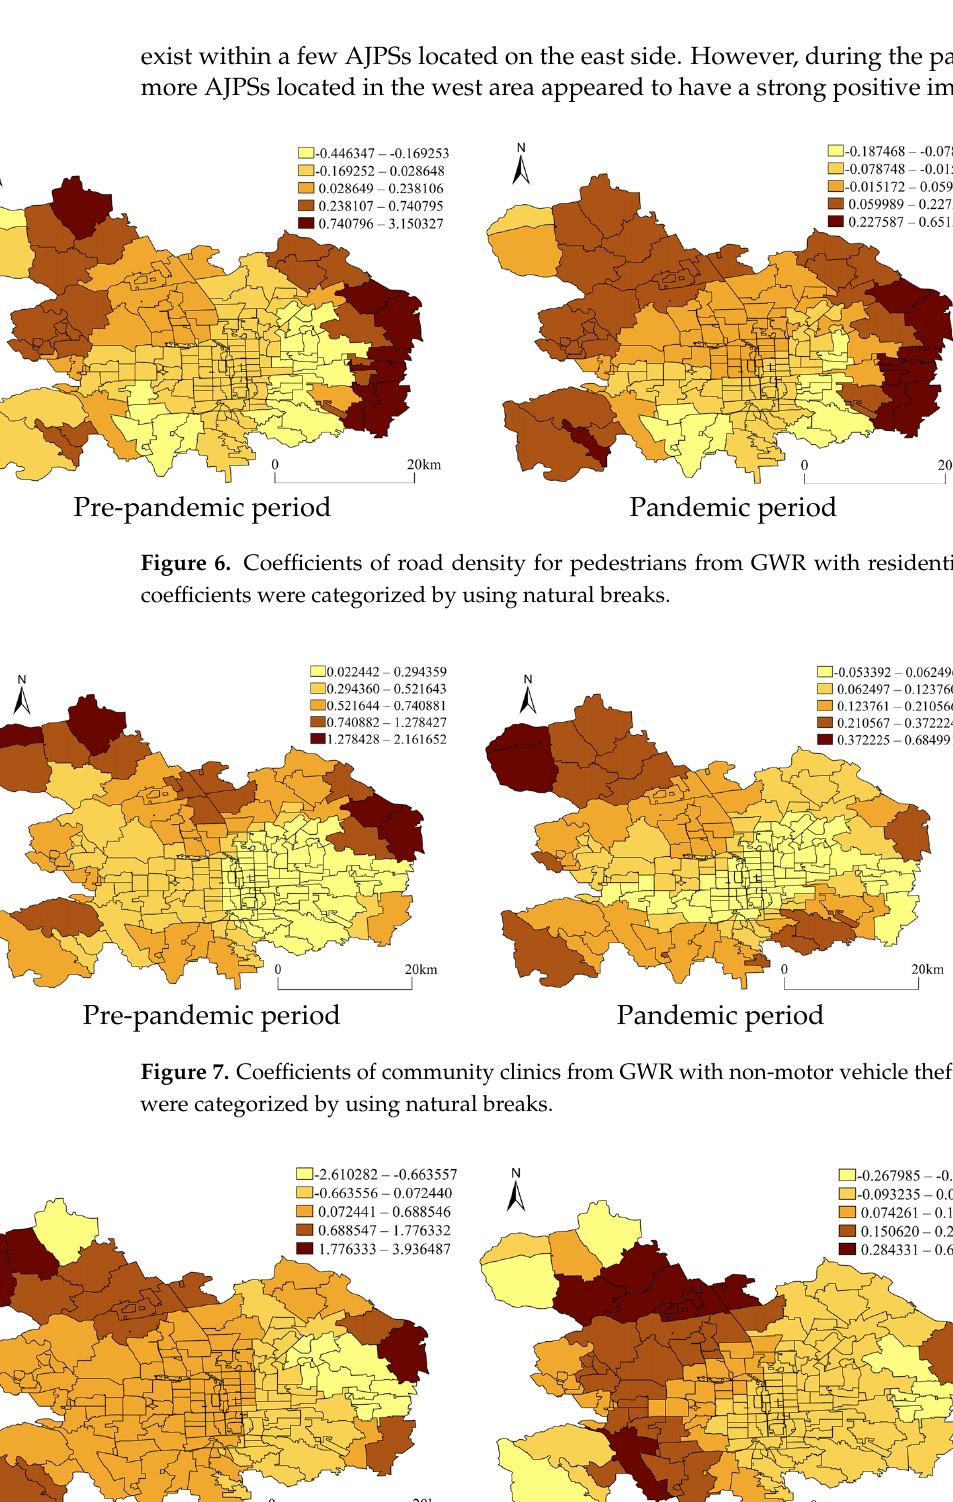
Figure 7. Coefficients of community clinics from GWR with non-motor vehicle theft. The coefficients were categorized by using natural breaks. Figure 8. Coefficients of road density for vehicles from GWR with non-motor vehicle theft. The coefficients were categorized by using natural breaks.